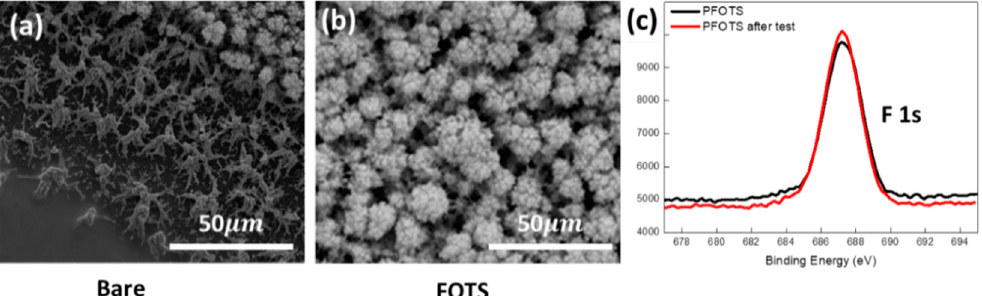
Figure 4. Top view of ( a ) bare and ( b ) PFOTS coated SnO 2 film after heat treatment at 300 °C, 99% RH for 1 h, and ( c ) XPS spectrum of F 1S peak of PFOTS coated SnO 2 film before and after heat treatment.